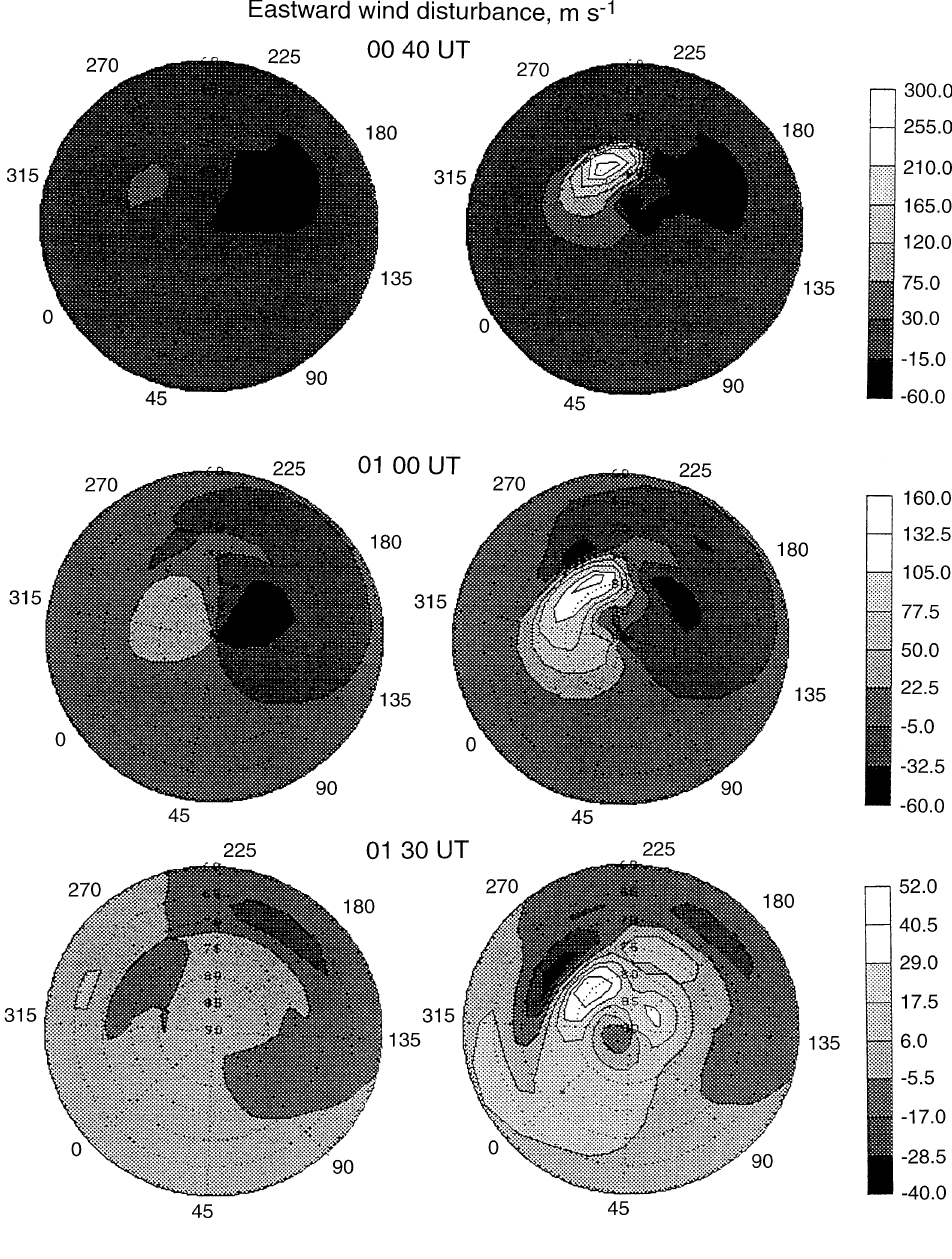
Fig. 10. The same as in Fig. 8 but for the zonal (positive eastward) thermospheric-wind- velocity disturbance at h " 300